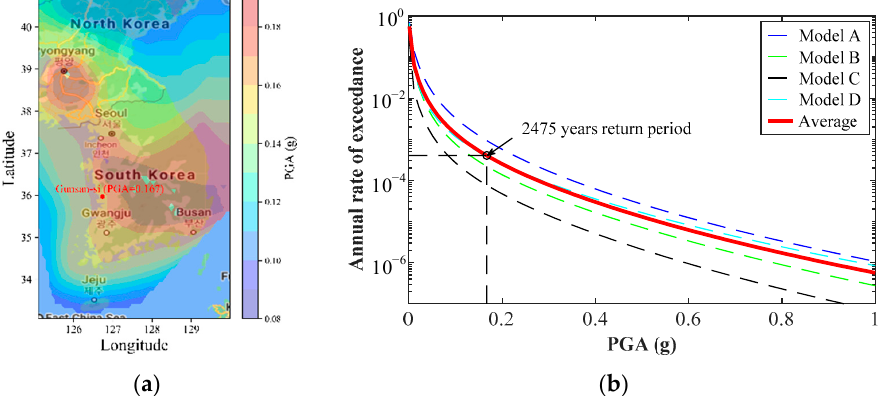
Figure 8. Seismic hazard evaluation: ( a ) seismicity maps in the Korean peninsula for 2475 years returned period; ( b ) seismic hazard curve in the building site (Gunsan-si, South Korea) for four seismic models in South Korea.